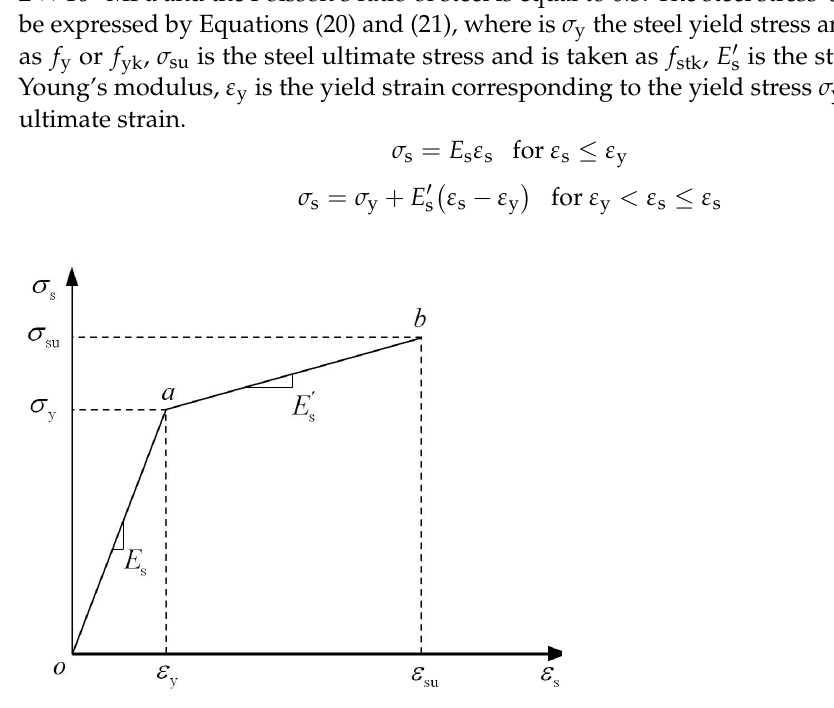
Table 2. Material Properties of Specimen